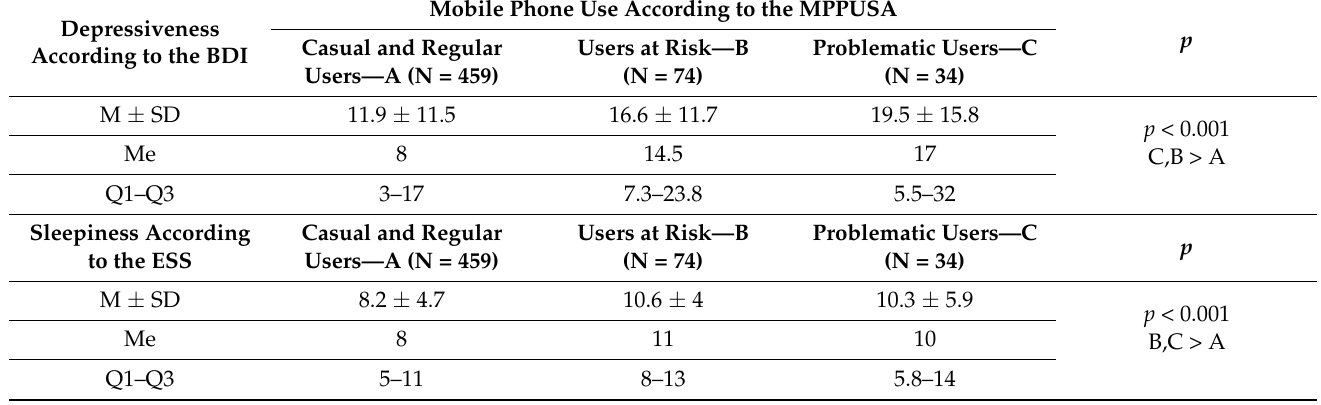
Table 2. The analysis of correlation between the mobile phone use according to the MPPUSA and the severity of depressiveness according to the BDI as well as daytime sleepiness according to the ESS.